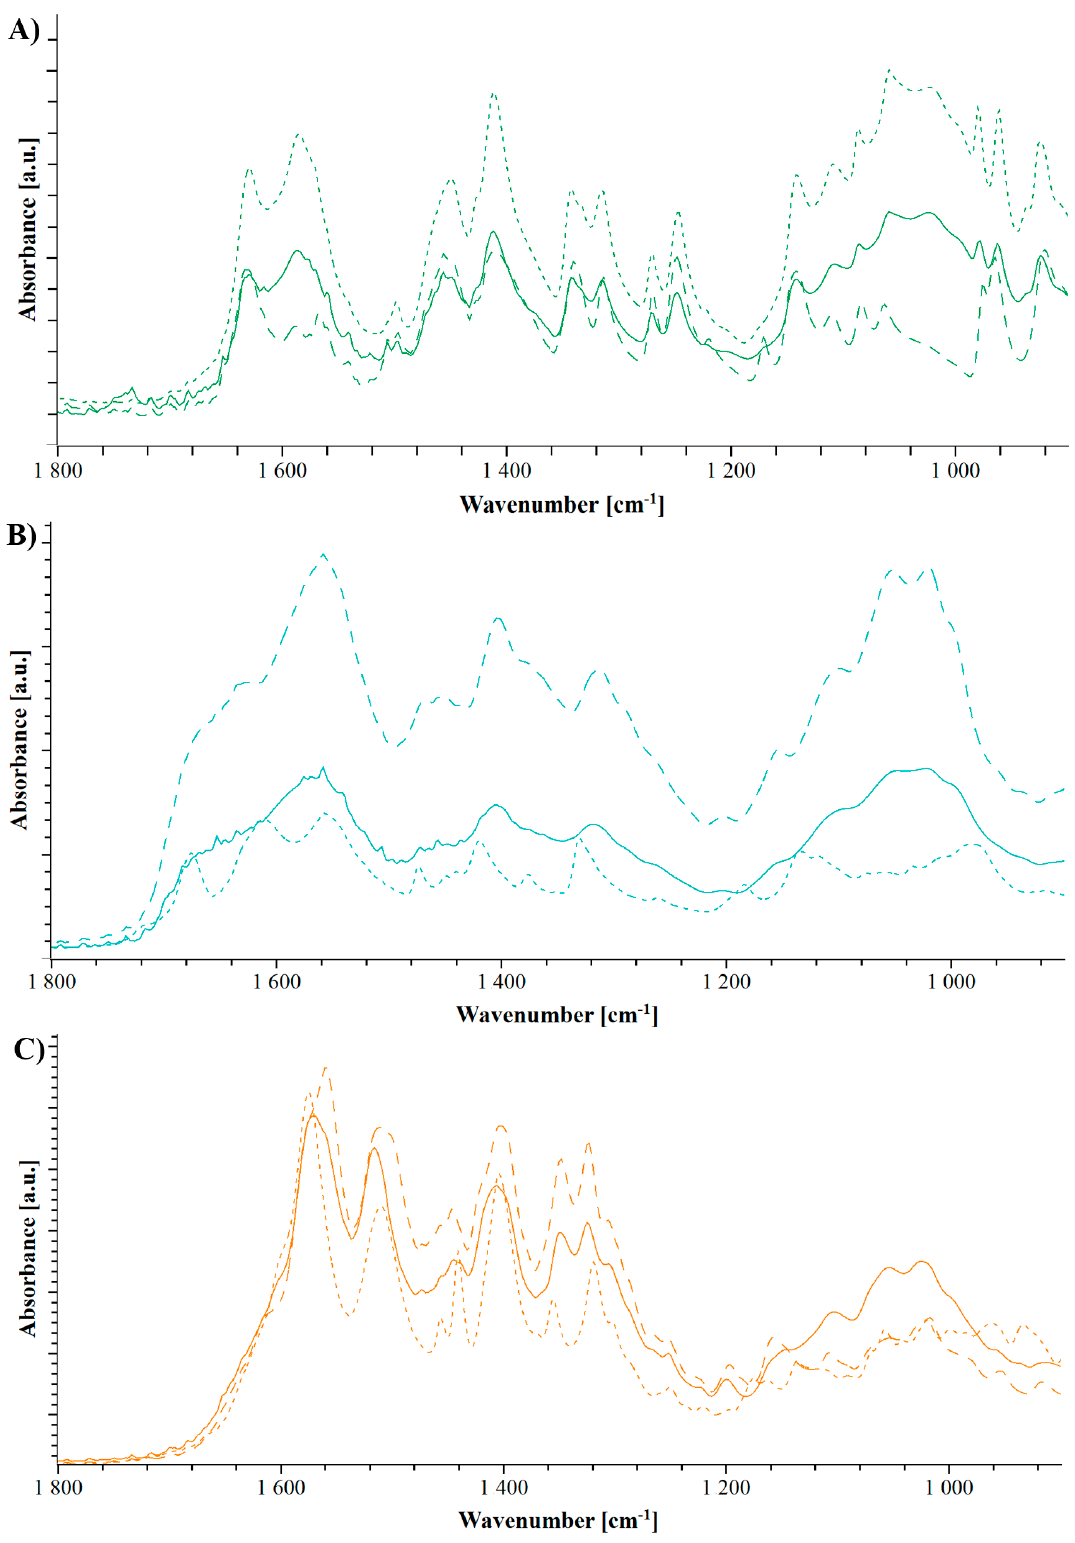
Figure 3. Fourier transform infrared spectroscopy (FTIR) spectrograms of NaCMC and histidine ( A , green), arginine ( B , cyan) and lysine ( C , orange). Dotted lines represent the physical mixture, dashed lines represent the solvent evaporates and the extrudates are shown in solid